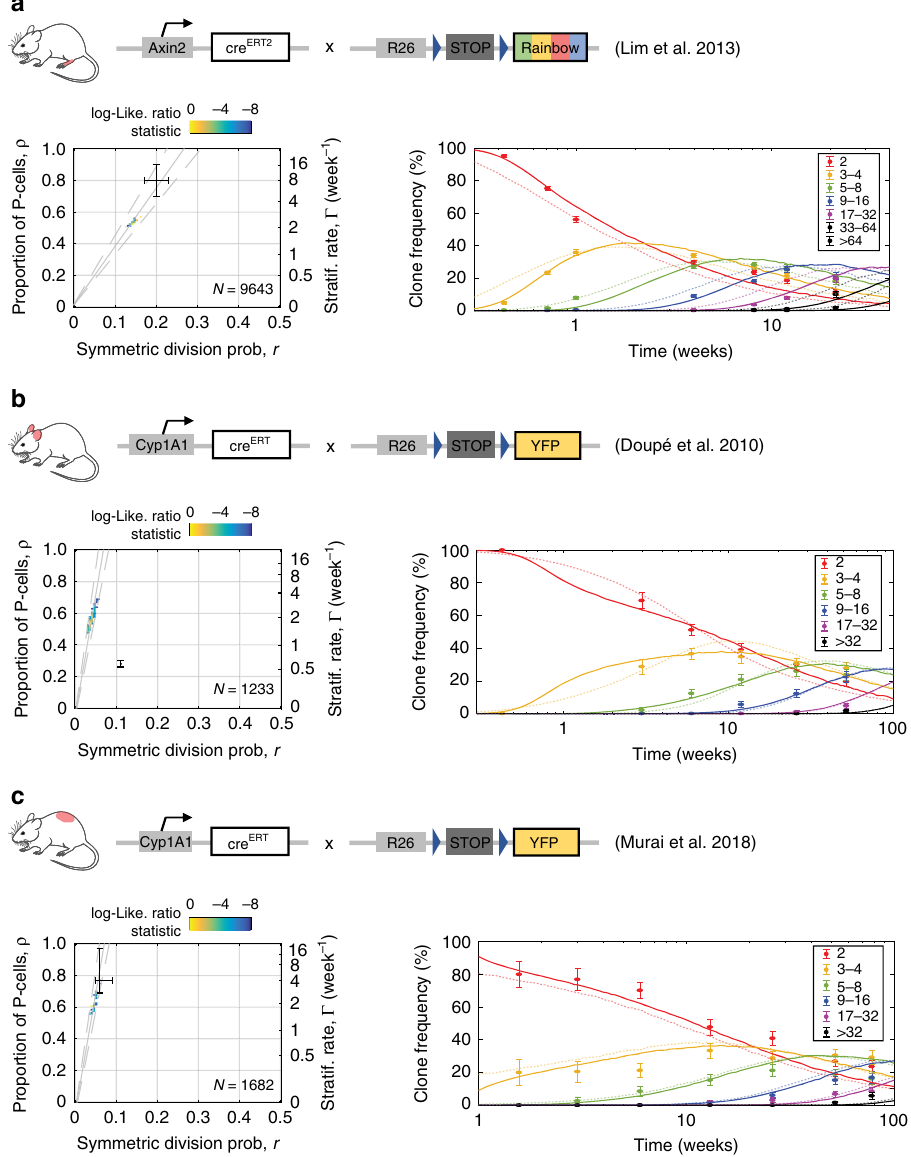
Fig. 8 The single-progenitor model fi ts clone dynamics in different regions of skin epidermis. a – c Left panels: SP-model parameter inference on lineage tracing data sets from paw epidermis 11 using Axin2-cre ERT R26 Rainbow animals ( a ), and ear 32 and dorsal 22 interfollicular epidermis in AhYFP mice ( b and c , respectively). Parameter estimates are obtained by MLE based on SP-model simulations constrained by the cell-cycle period distribution inferred from each corresponding cell-proliferation analysis. Regions within the dashed gray lines fall consistent with the predicted ρ / r ratios from the linear scaling of the average clone size. The total number of clones counted in each data set is displayed in the corresponding graph. Black bars are parameter estimates given in the original publications shown, centre is the mid range and bars indicate the maximum and minimum plausible parameter values in simulations in each paper ( a , b , c ). Right panels: Experimental Axin2- ( a ; from ref. 11 ) and Ah - ( b and c ; from refs. 32 and 22 ) derived basal-layer clone sizes (dots indicate mean ± standard error of proportion) give an excellent fi t with the SP model with gamma-distributed cell-cycle times (lines; prediction from MLE). Dim dashed lines: fi ts obtained with parameter estimates given in the original publications. Frequencies for each clone size (basal cell number) are shown in different colors. See Supplementary Data 4 for goodness-of- fi t intensities were determined by image segmentation/nuclear identi fi cation, using a of 1 in 301± 106 (mean± s.e.m.) basal cells by 10 days post induction (allowing semi-automated object-recognition macro (based on the DAPI channel) built in individual clone tracking without merging). Between three and six mice were culled ImageJ, and the process completed by manual curation. Per-cell intensity values per time point. Confocal images of immunostained wholemounts were acquired on given are averaged over all nuclear pixels. All H2BGFP samples were stained for a Leica TCS SP8 confocal microscope (×10, ×20, and ×40 objectives; typical settings CD45 and positive cells excluded from the analysis. for z -stacks acquisition: optimal pinhole, line average 4, bi-directional scan with 400 – 600 Hz speed, resolution of 1024 × 1024 pixels). The number of nucleated basal and suprabasal cells per labeled clone was Lineage tracing . Low-frequency expression of the Confetti reporters in the Lrig1- counted under live acquisition mode. GFP-labeled clones were not scored due to the dif fi culty of distinguishing them from the constitutive basal GFP expression eGFP-ires-cre ERT2 R26 fl Confetti/wt mouse esophagus was achieved by inducing 10- driven by the Lrig1 cassette. CFP, RFP, and YFP clones were pooled together for week-old animals with intraperitoneal injection of a single dose of 1mg tamoxifen further analysis (histograms (distributions) of basal-layer clone sizes and average (100 μ l of 10 mg/ml) on two consecutive days 8 . This resulted in a labeling ef fi ciency